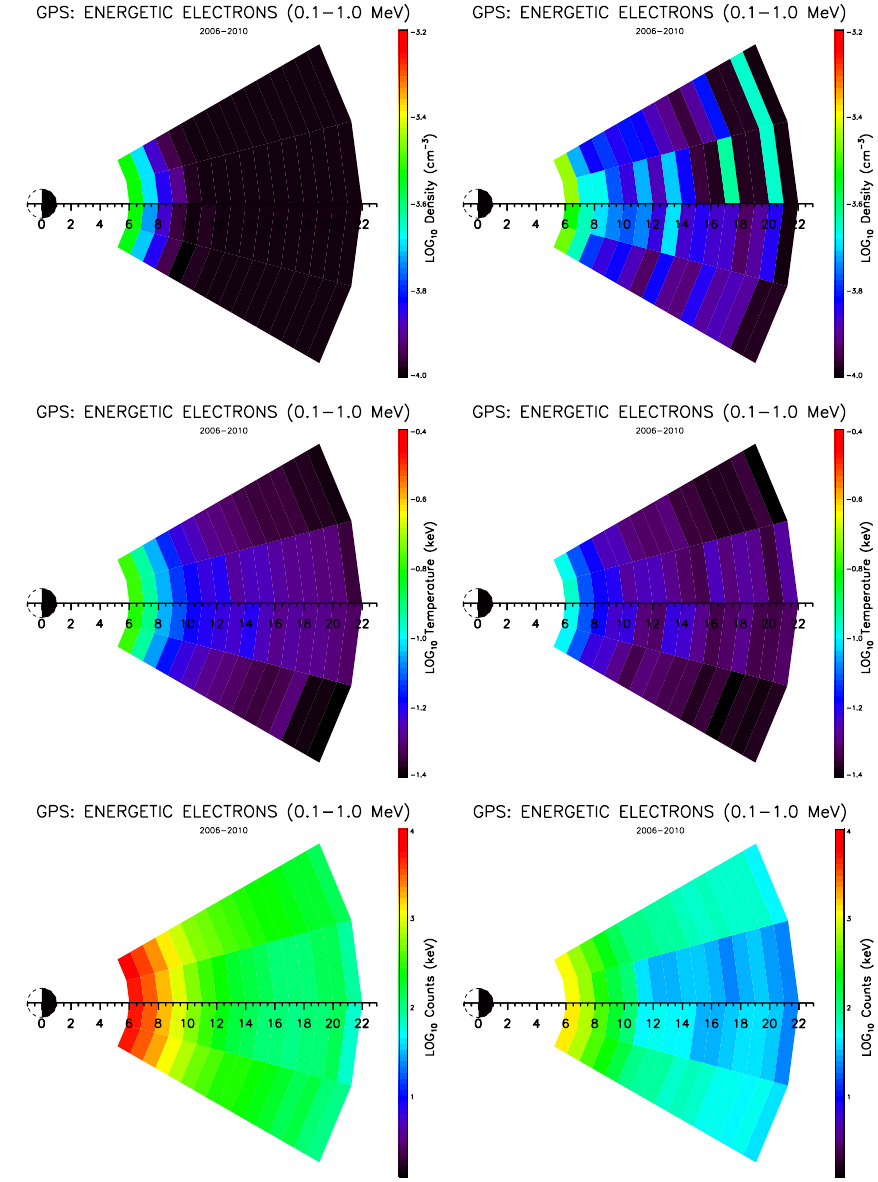
Fig. 5. Plots of the averaged energetic electron density ( N : top row), temperature ( T : middle row) and counts (bottom row) derived from measurements by GPS spacecraft at high-latitude and then mapped to the equatorial plane using the Tsyganenko T89 model as a function of LT and L for quiet geomagnetic conditions (left column: Kp=0–2: 66464 data points), disturbed geomagnetic conditions (right column: Kp > 3: 14095 data